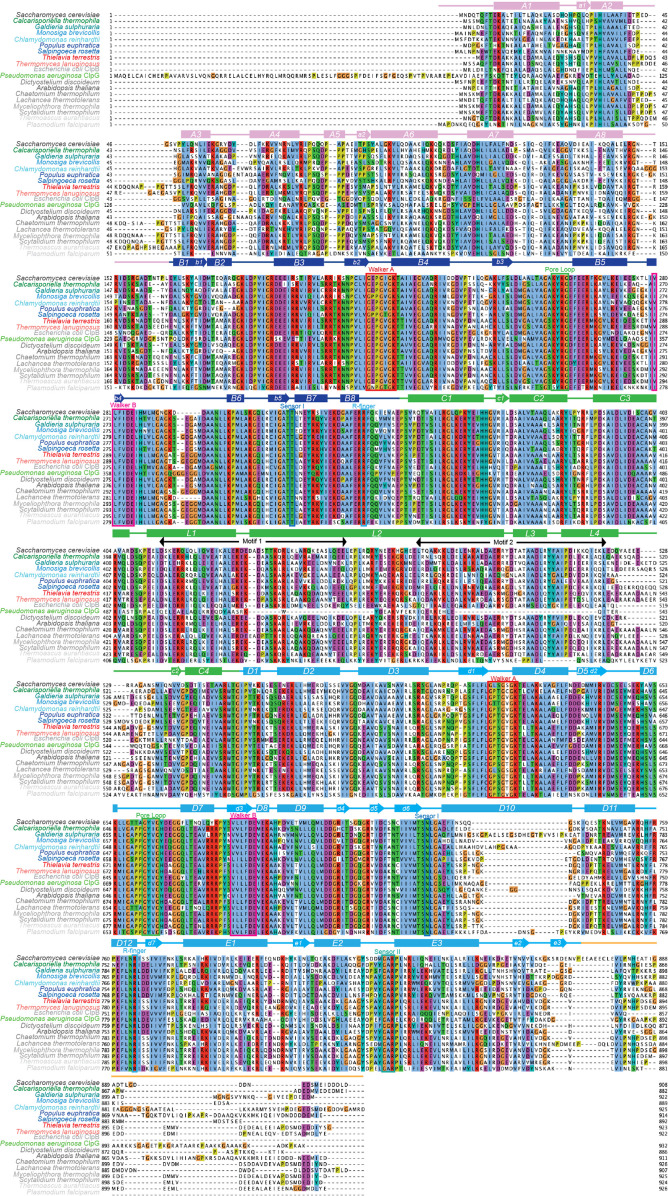
Alignment of all Hsp104 homologs investigated in this study.Amino acid sequences of Hsp104 homologs were aligned using Clustal Omega, and the multiple sequence alignment was visualized with JalView. Positions in the alignment are colored by Clustal X convention: conserved hydrophobic positions (A,I,L,M,F,W,V,C) are blue; conserved basic residues (K,R) are red; acidic residues (E,D) are magenta; polar residues (N,Q,S,T) are green; aromatic residues (H,Y) are cyan; conserved cysteines are pink; glycines are orange, prolines are yellow. Structural elements of Hsp104 are indicated. C. thermophila and ClpG are in green, TDP-43-specific homologs are colored in shades of blue, αSyn-specific homologs are colored in red, and non-rescuing homologs are colored in shades of gray.